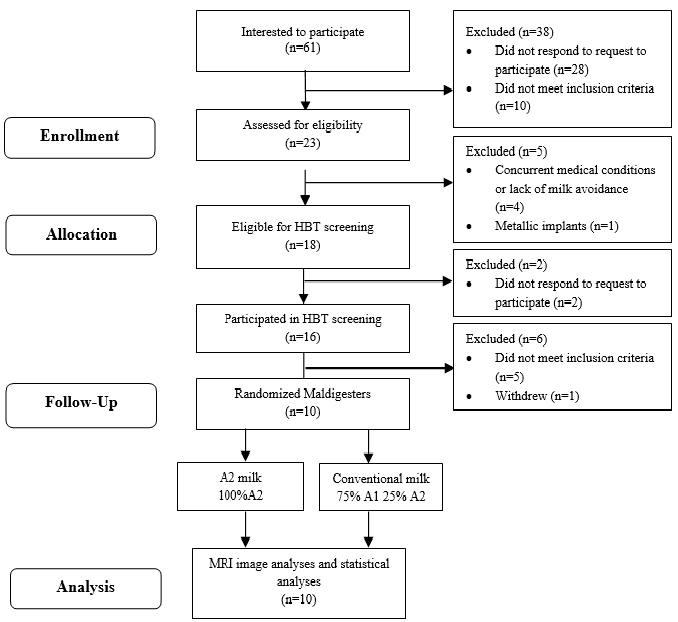
Figure 1. Study flow. HBT, hydrogen breath test; MRI, magnetic resonance imaging analysis.